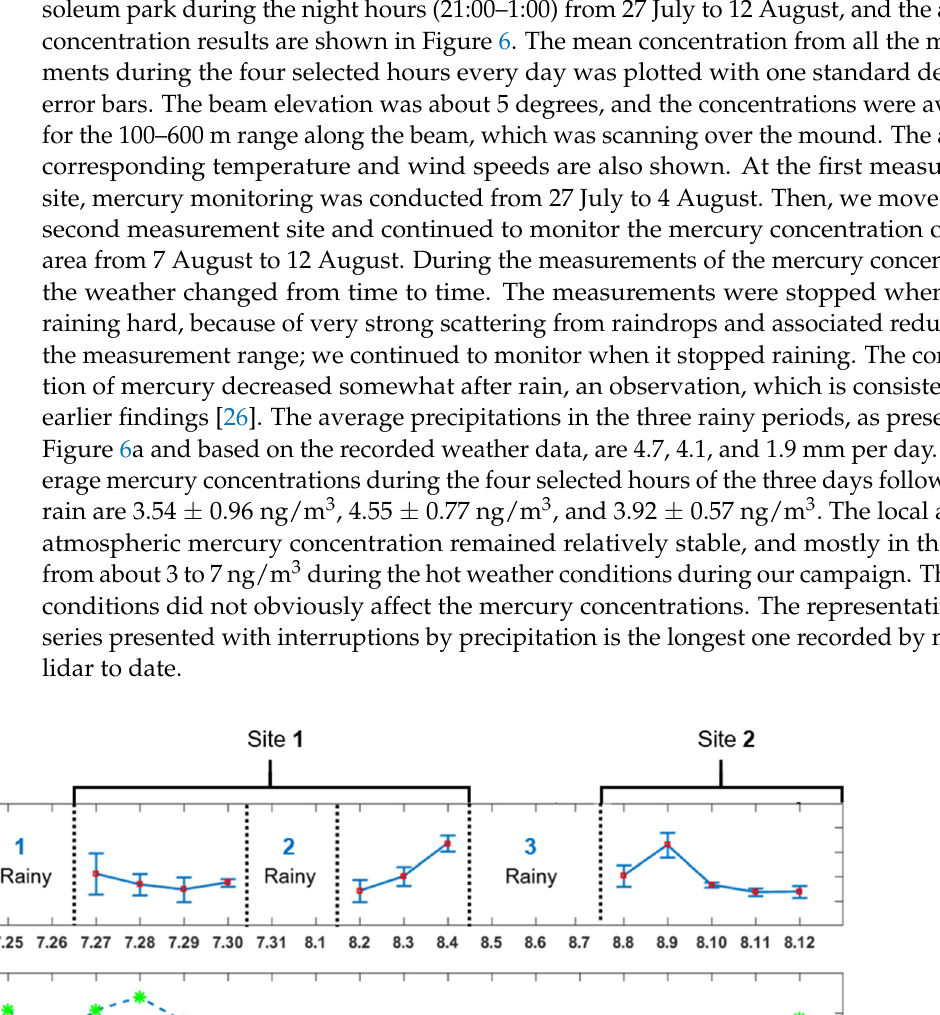
Figure 5. Comparison of mercury concentrations in two different directions. The light blue arrow is directed towards the suburban area and the blue arrow towards the Lintong urban area. The green dashed line indicates the position of the emperor Qin tomb mound.